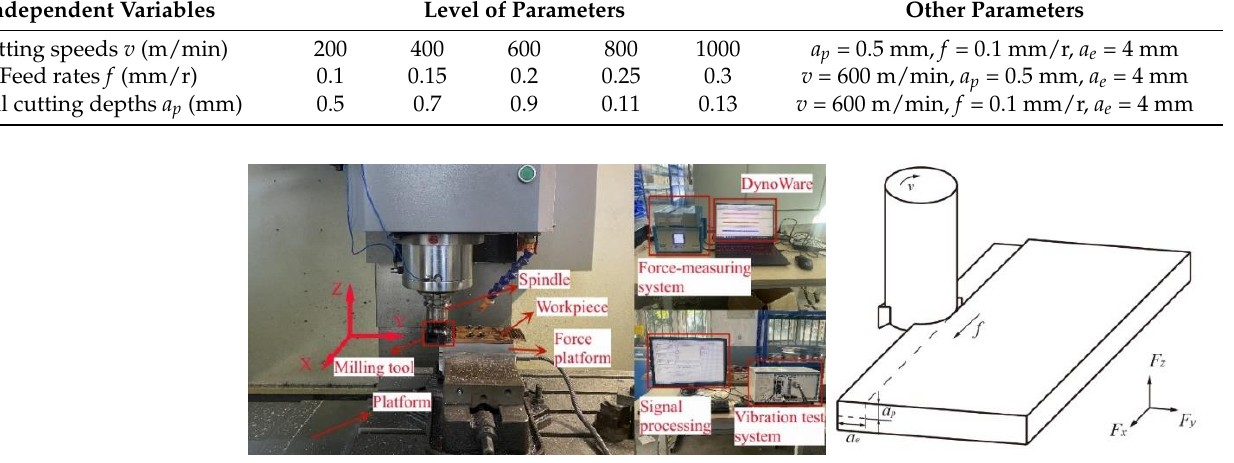
Figure 3. Milling test equipment and schematic diagram of milling processing.